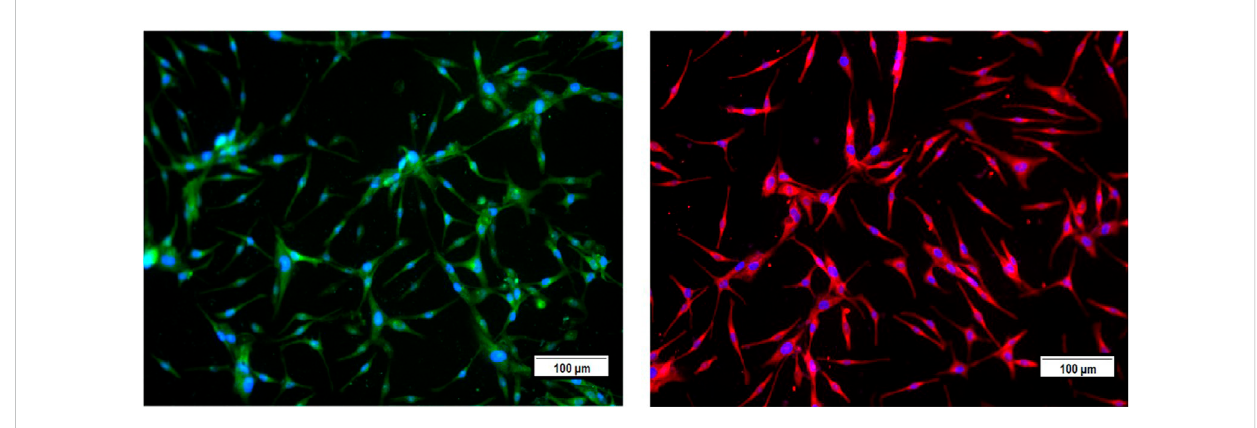
FIGURE 1 Characterization of the primary culture of melanocytes from neonatal foreskin by detecting the expression of melanosomal glycoproteins TRP-1 (left) and TRP-2 (right) using immuno fl uorescence